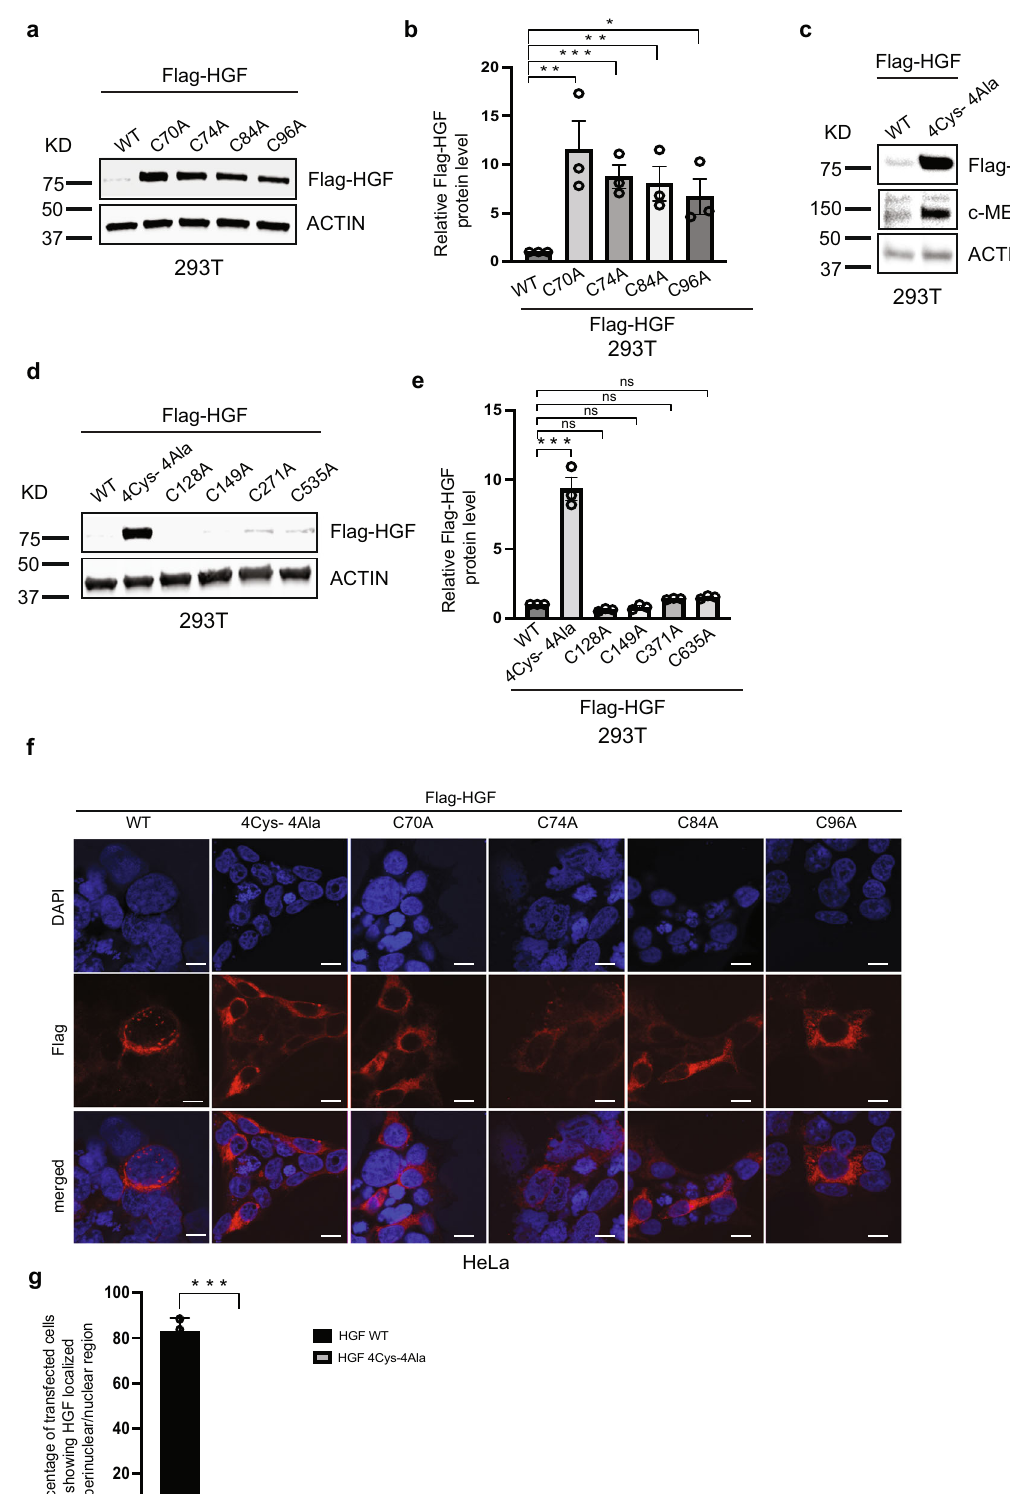
None of these mutant HGFs showed increased protein expression when expressed exogenously in cells as did the HGF 4Cys-4Ala (Fig. 1d, e). Thus, cysteine residues in the kringle and SPH domains are apparently not involved in HGF abundance. Rather, induced expression of HGF is speci fi cally de fi ned by the four strictly conserved cysteine residues in PAN